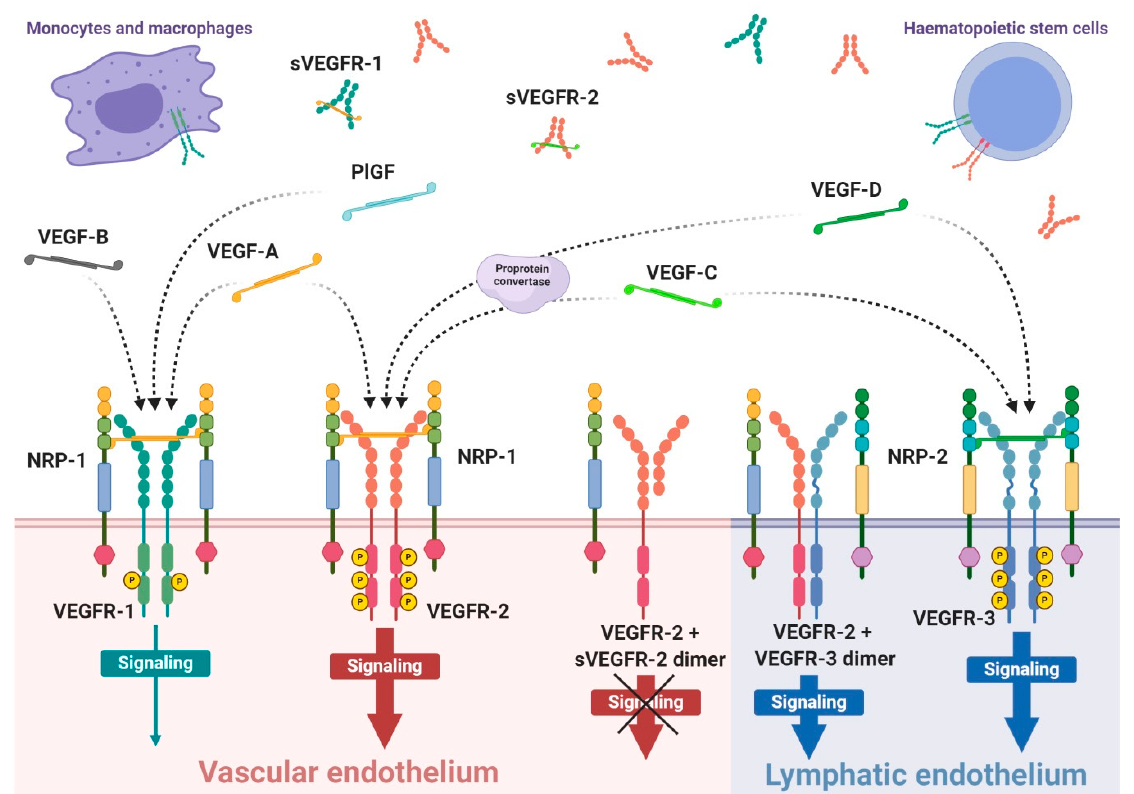
Figure 1. Scheme of expression of VEGF receptors and specificity of VEGF ligands. VEGF receptors occurs mainly as the homodimer transmembrane receptor tyrosine kinases, known as VEGFR-1, VEGFR-2 and VEGFR-3, or in soluble forms defined as sVEGFR-1 or sVEGFR-2. Moreover, surface receptors can create mixed heterodimers or even dimerise with soluble forms. VEGFR-1 expression occurs on vascular endothelium as well as haematopoietic stem cells, macrophages and monocytes. Expression on VEGFR-2 occurs mainly on vascular endothelium, less often on lymphatic endothelium, as well as on the surface of haematopoietic stem cells. The third receptor is mosty expressed on lymphatic endothelium. Conjugation of soluble form with transmembrane receptor preclude VEGF-driven signaling inside the cell. The mammalian VEGF glycoproteins, VEGF-A, VEGF-B, VEGF-C, VEGF-D and PlGF, are expressed as dimers that create different interations with specific VEGFRs, which is indicated by the dashed arrows. Representative VEGF-A glycoprotein binds to VEGFR-1 and VEGFR-2 with significantly higher affinity towards the first receptor. Concomitantly, VEGFR-1 is a specific molecular target for VEGF-B and PlGF, while VEGF-C and VEGF-D selectively bind to VEGFR-3; however, after proteolytic maturation, both VEGF-C and VEGF-D can also bind to VEGFR-2.